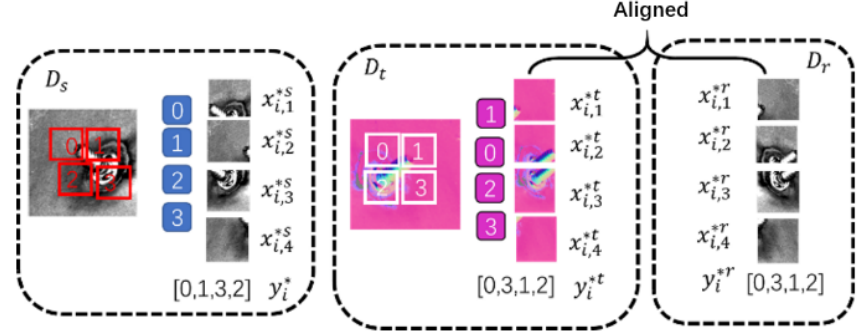
Figure 2. Schematic diagram of jigsaw pre-order task.